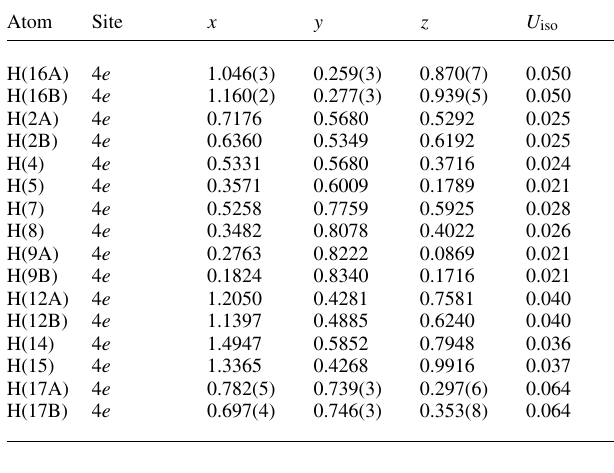
Table 3. Atomic coordinates and displacement parameters (in Å 2 ) .